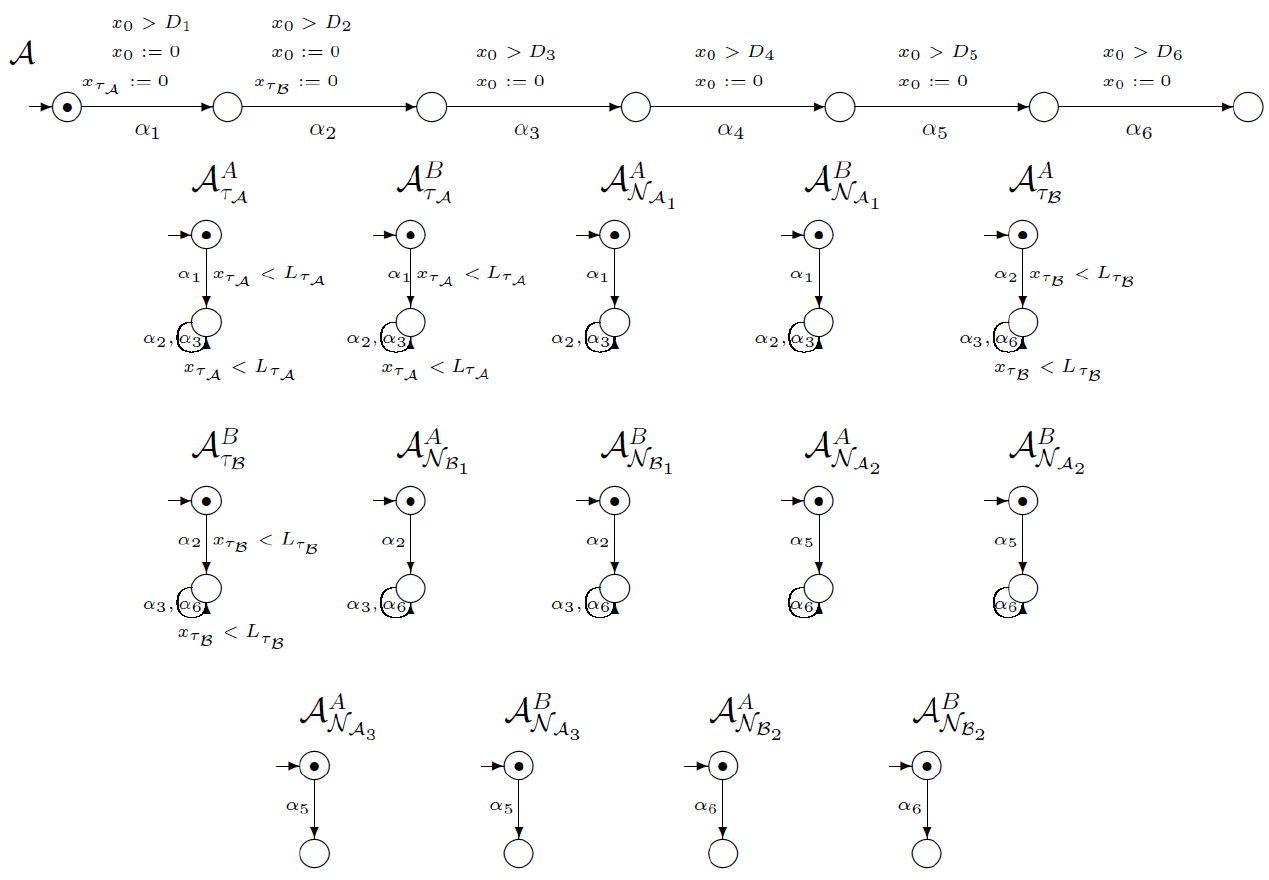
Figure 8. Network of synchronised timed automata for SNEP protocol